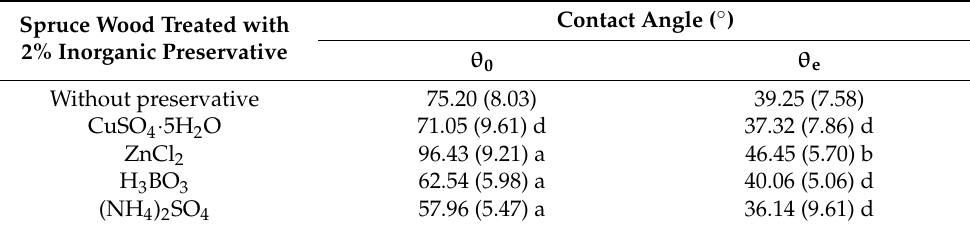
Table 1. Wettability of spruce wood surfaces treated with 2% inorganic wood preservatives— characterized by the θ 0 “initial contact angle” and the θ e “equilibrium contact angle”. Contact Angle ( ◦ ) Spruce Wood Treated with 2% Inorganic Preservative θ 0 θ e Without preservative 75.20 (8.03) 39.25 (7.58) CuSO 4 · 5H 2 O 71.05 (9.61)